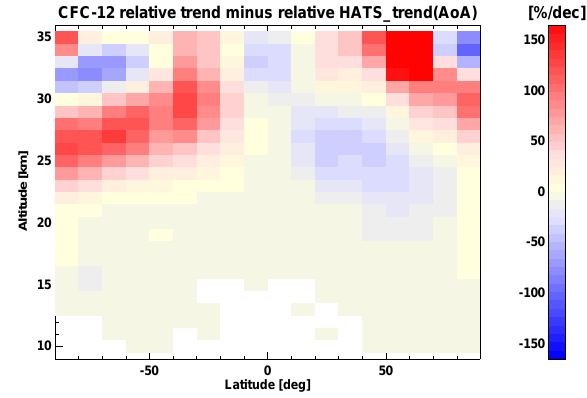
Fig. 16. As for Fig. 13 but for CFC-12. Numerical values are found Fig. 16. As for Figure 13 but for CFC-12. Numerical values are in the found in the supplement.